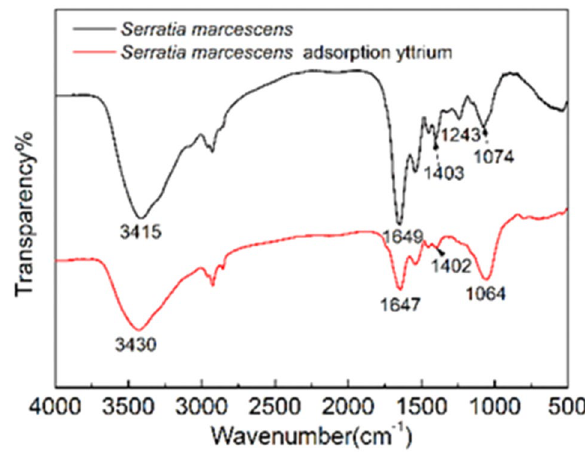
Figure 6. FT-IR spetra of S. marcescens before and after Y(III)